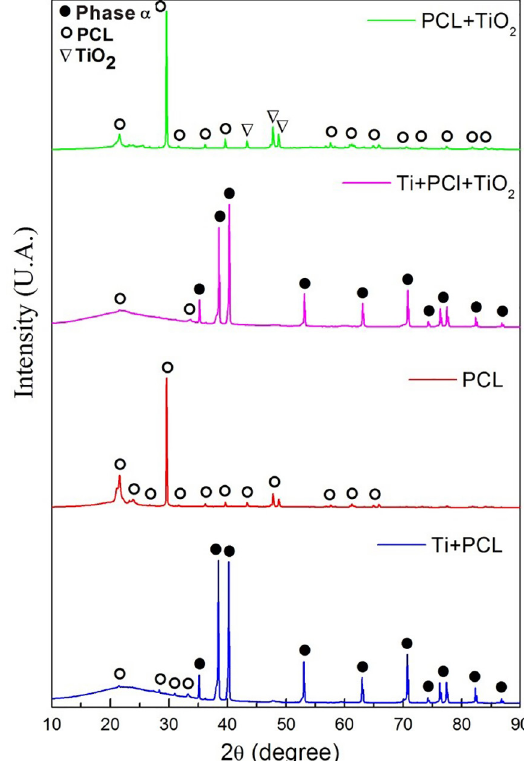
Figure 3. X-ray Diffractograms of (blue) Ti cp+PCL, (red) PCL film. film, (pink) Ti cp+PCL+TiO 2